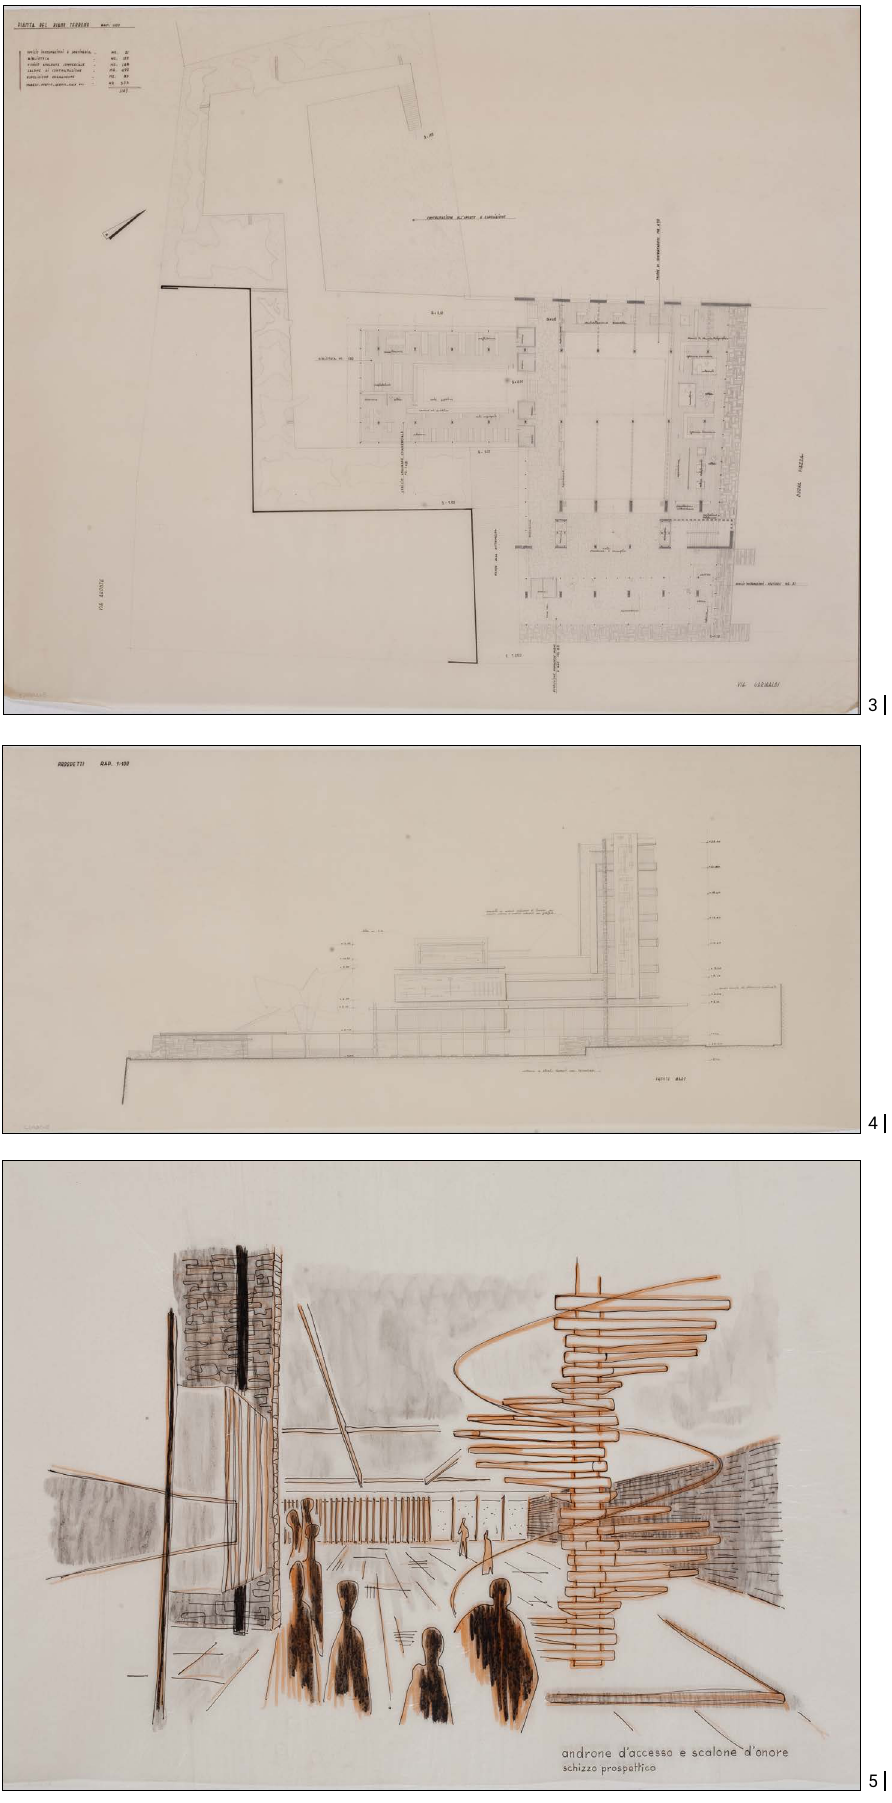
Project for the Commerce Chamber of Carrara, sketch of the entrance hall; CSAC,